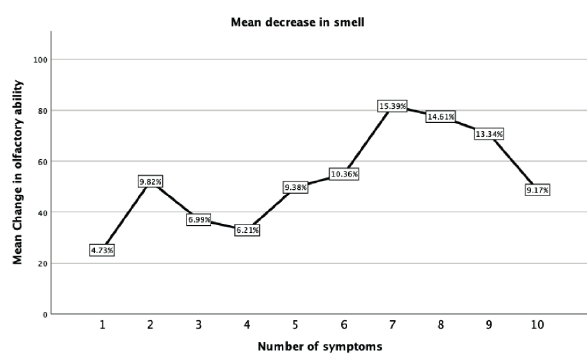
Figure 5. Change in olfactory ability compared to the number of symp- toms. In the boxes is noted the percentage of patients suffering from the corresponding number of